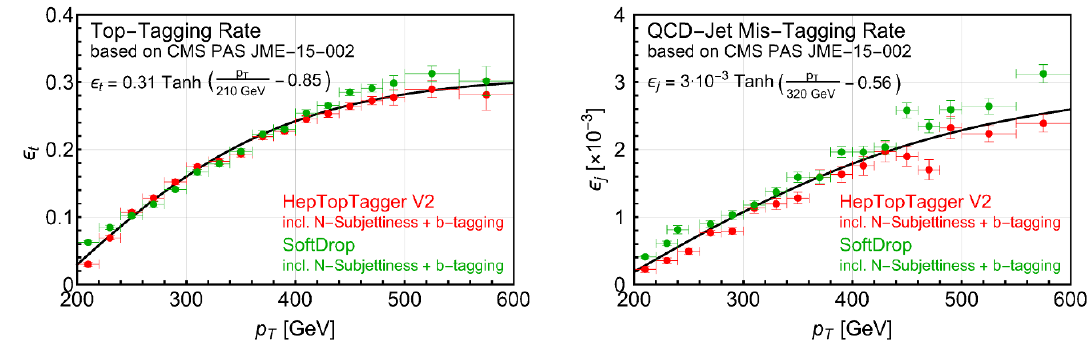
Figure 8 . Top-tagging e(cid:14)ciencies (left) and QCD-jet mis-tagging rate (right) for the HEPTopTag- ger (red) and SoftDrop (green) as adapted from the CMS study [70]. The analytic parameterization used in this study is shown as a solid black